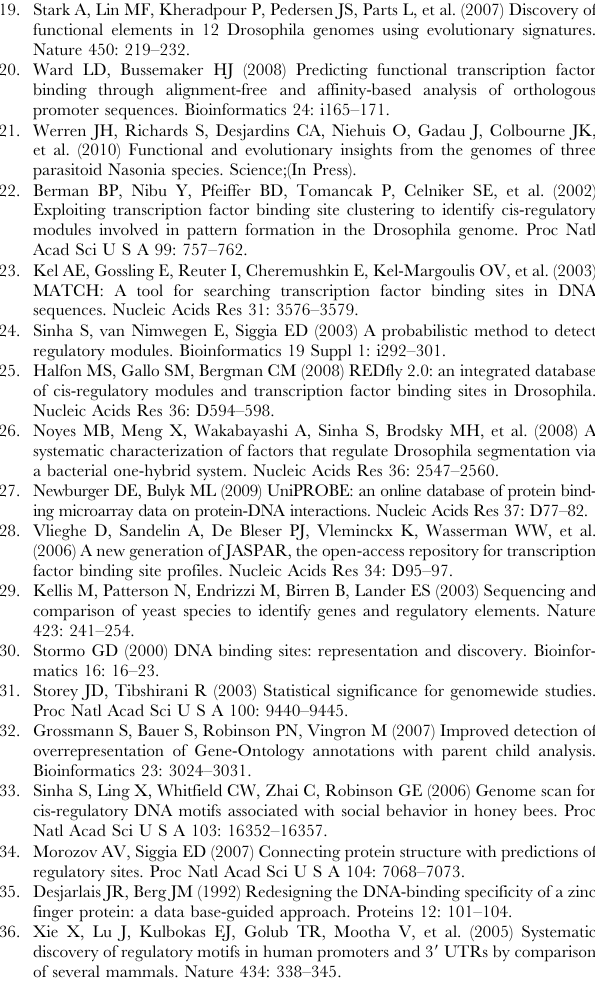
Table S4 Alignments of DNA-binding domains in orthologous protein sequences from Drosophila and Nasonia .